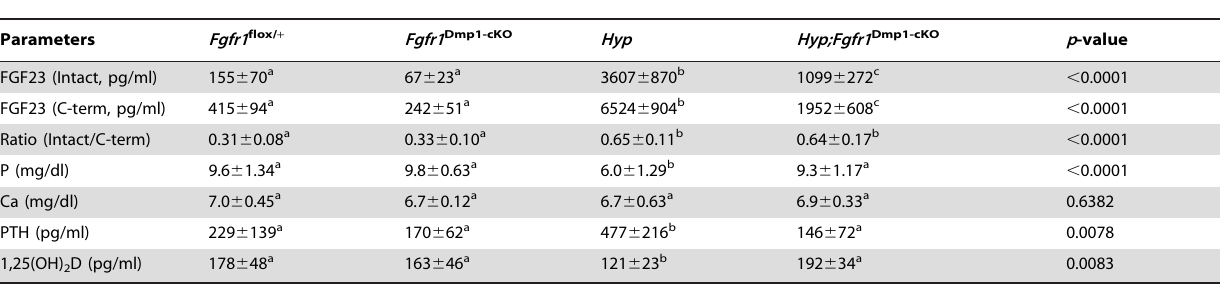
Table 2. Biochemistry analysis in 6-week-old